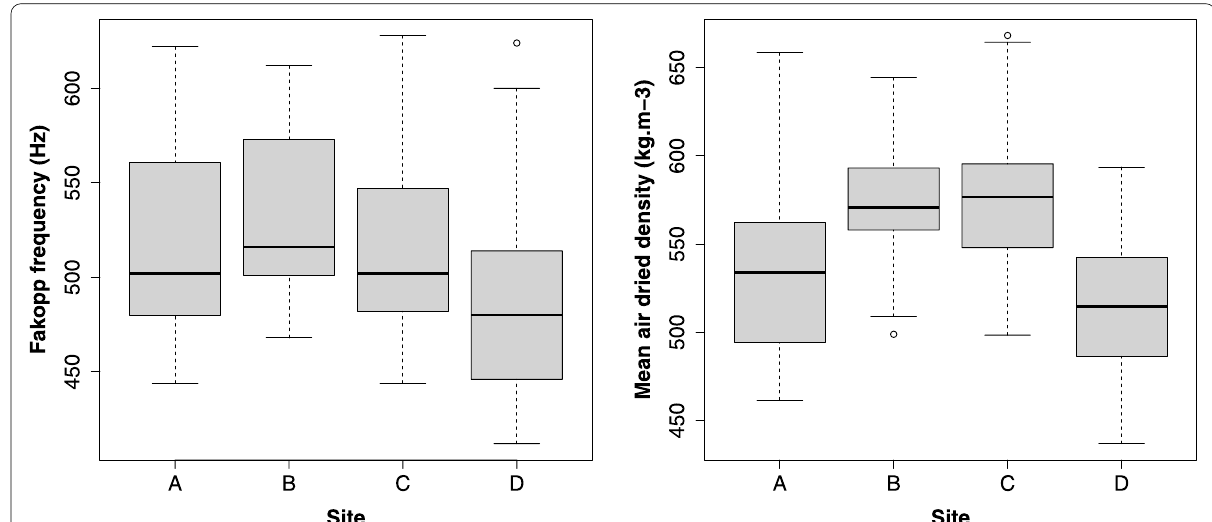
Fig. 2 Characteristics of the four stands with respect to some log-level variables: log frequency (on the left) and mean air‑dried density (on the right). Mean air‑dried density of logs was obtained by weighting disc densities (see Section 2.3) by disc areas at both log ends